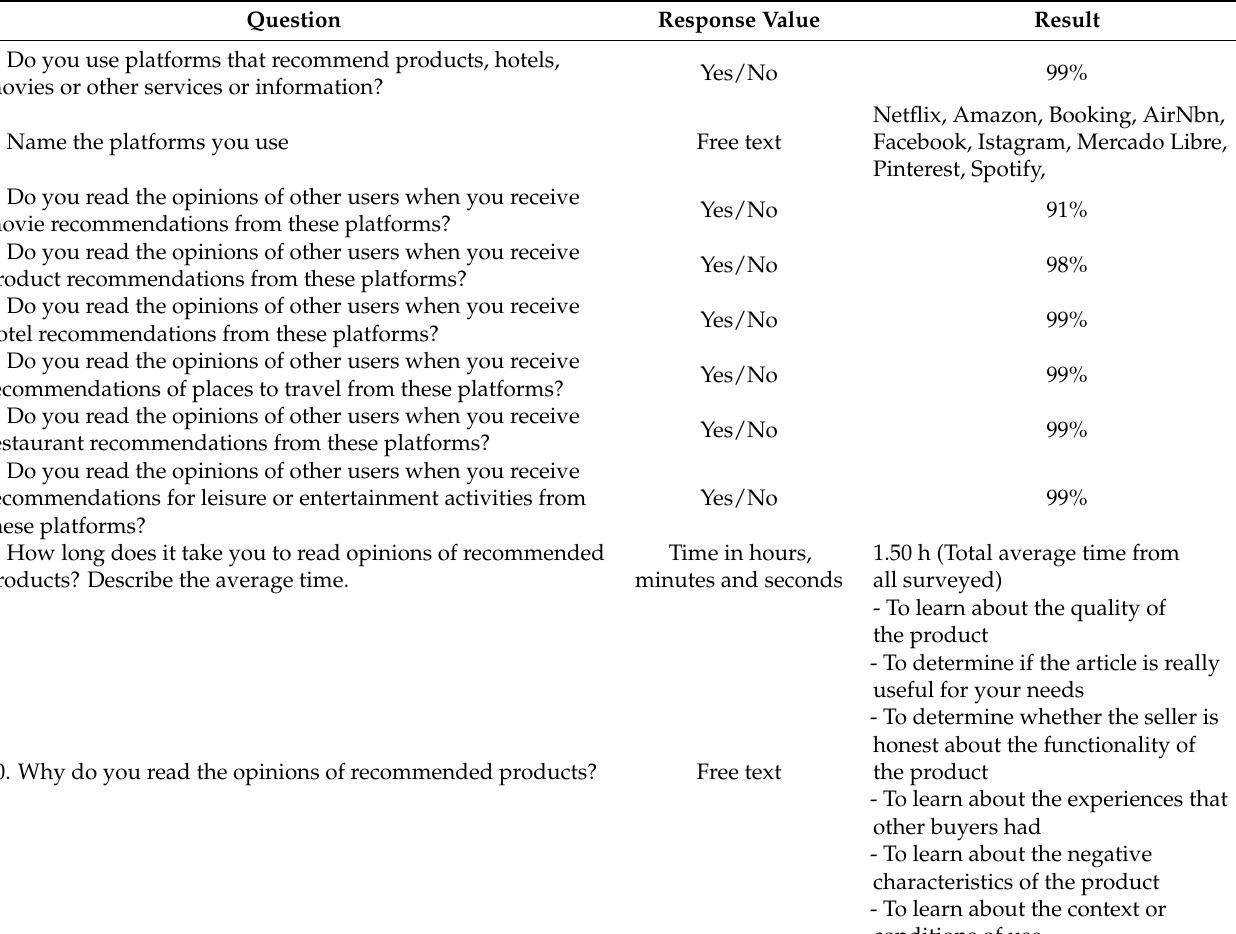
Table 1. Questions and results of the survey of users of recommender